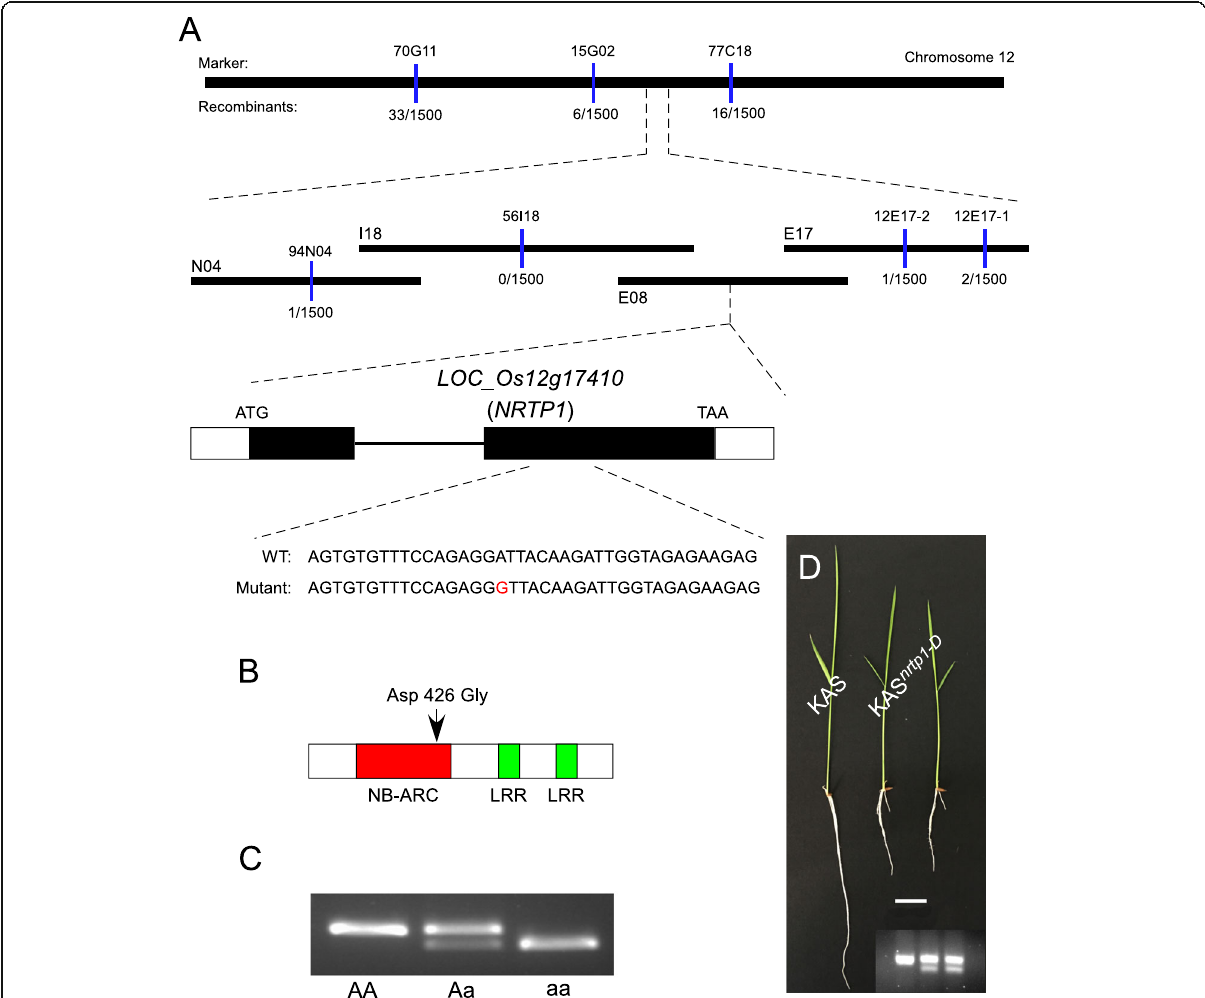
Fig. 2 Map-based cloning of NRTP1 . ( a ) Physical map of the NRTP1 locus. The number of recombinants per 1500 meioses is indicated for each molecular marker represented by blue bars. N04, I18, E08 and E17 are abbreviations of BAC clones corresponding to OSJNBa0094N04, OSJNBa0056I18, OSJNBb0071E08 and OSJNBb0112E17, respectively. For the structure of the NRTP1 gene, two boxes indicate the two exons and the line indicates the intron. ( b ) Structure of the NRTP1 protein. Arrow indicates the substitution in the 426-amino-acid protein in the nrtp1-D mutant. ( c ) A derived cleaved amplified polymorphic sequences (dCAPS) marker differentiates the wild type, heterozygous and homozygous mutant. ( d ) Complementation test. KAS nrtp1-D , two independent transgenic lines harboring mutated DNA fragmentexhibited the heterozygous nrtp1-D mutant phenotype. KAS, wild-type control. Insertion is the dCAPS marker confirmation of transgenic lines. Bar = 2